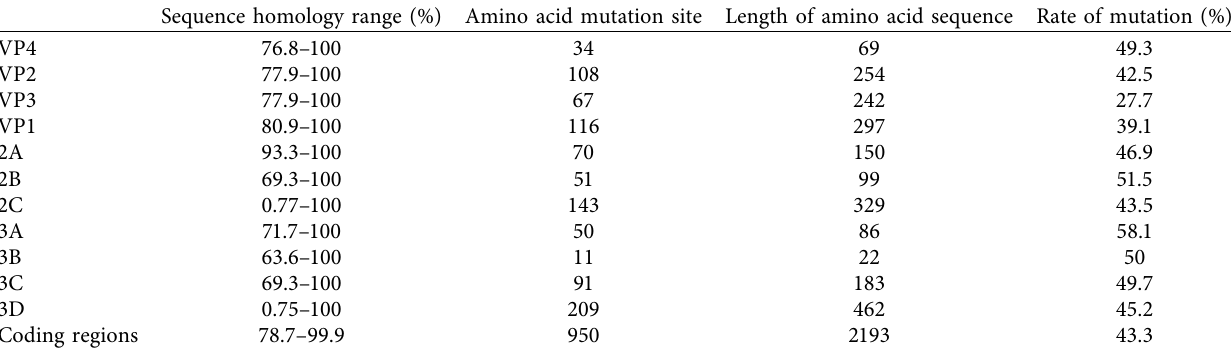
Table 3: Comparison of the nucleotide and amino acid identities of the Chinese EV-A71 strains.